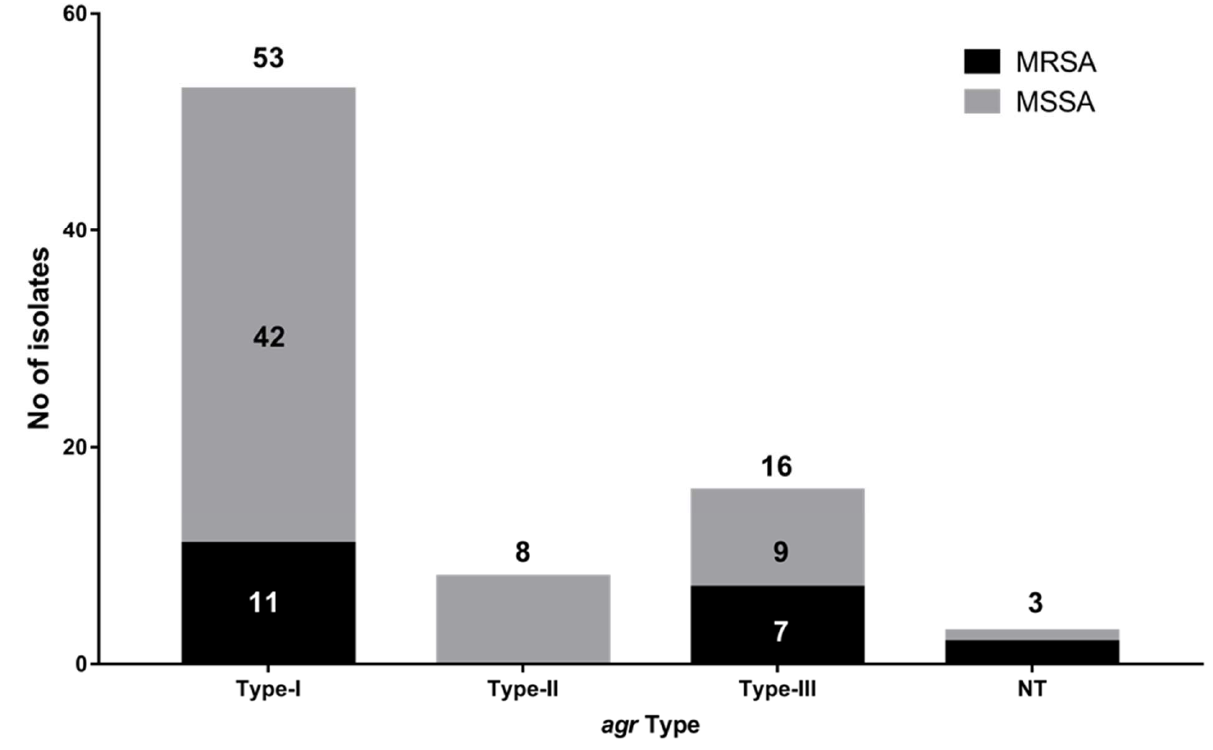
Figure 2. Molecular characterization of the S. aureus clinical isolates using accessory gene regulator locus ( agr ) typing: agr Type-I was the most common among the isolates followed by type III. Type- II was not found in the MRSA isolates but there were 2 and 1 NTs in MRSA and MSSA,